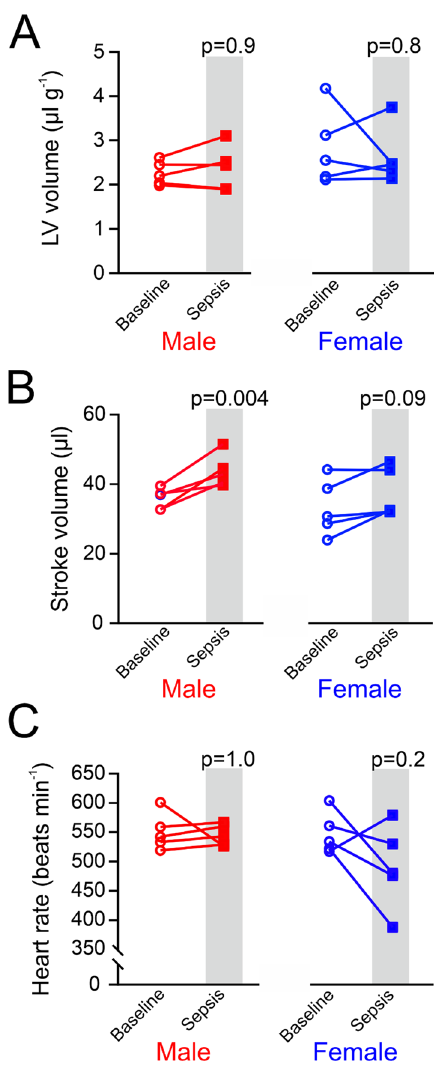
Fig. 3 Serial echocardiography in wild-type female and male mice before and after polymicrobial sepsis. A Left ventricular volume (standardised by body weight) in wild-type male and female mice ( n as indicator of preload 18 h after the onset of sepsis. B Stroke volume in male and female mice ( n sex). Stroke volume increased only in both wild-type male mice 18 h after the onset of sepsis. C Heart rate in wild-type male and female mice, as indicator of preload 18 h after the onset of sepsis. D Data for each individual mouse were compared to its own pre-sepsis baseline reading, measured ~ 1 week before the onset of sepsis. Individual p values on each panel refer to post hoc testing after ANOVA testing for sex x time